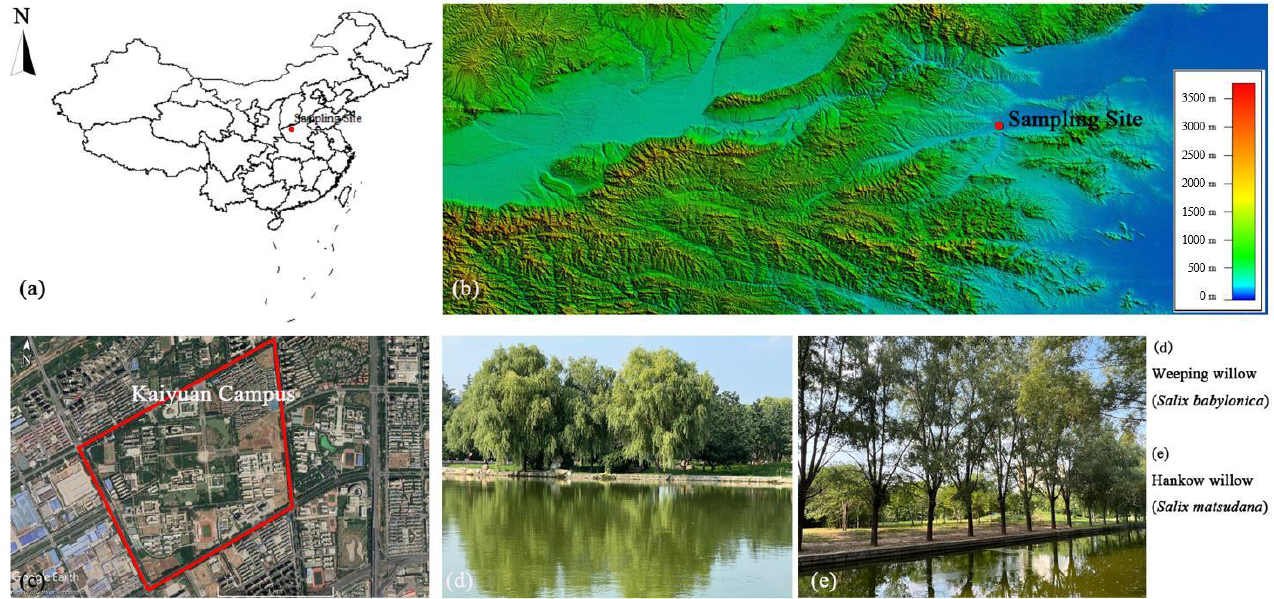
Figure 1. Geographical location of study site in central China ( a , b ), the study area landscape from Google Earth ( c ), and the photos of two tree species ( d , e ). Species photos were taken by Pengfei Luo.